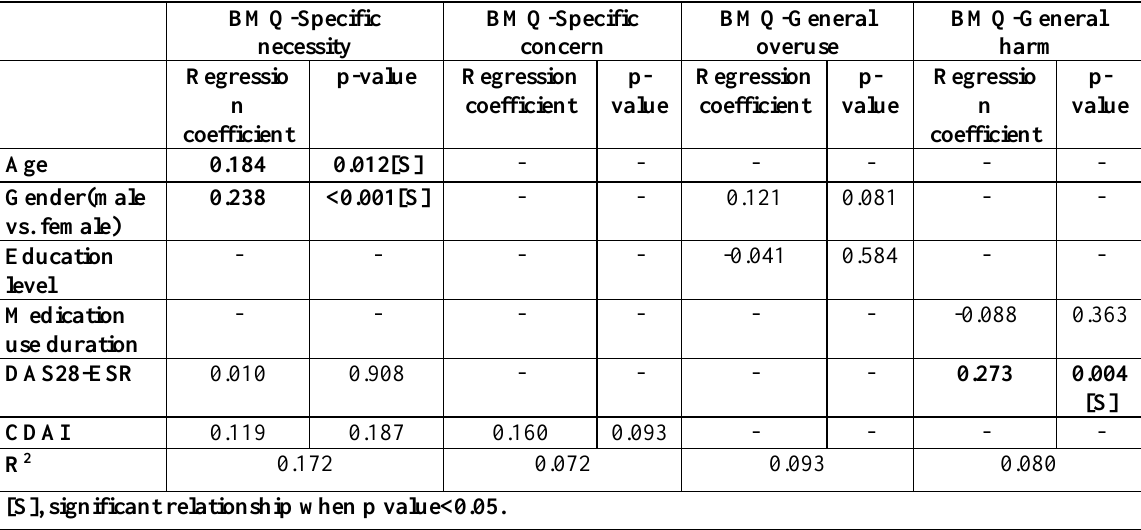
Table 6. Multivariate Linear regression analysis between BMQ components and other variables of